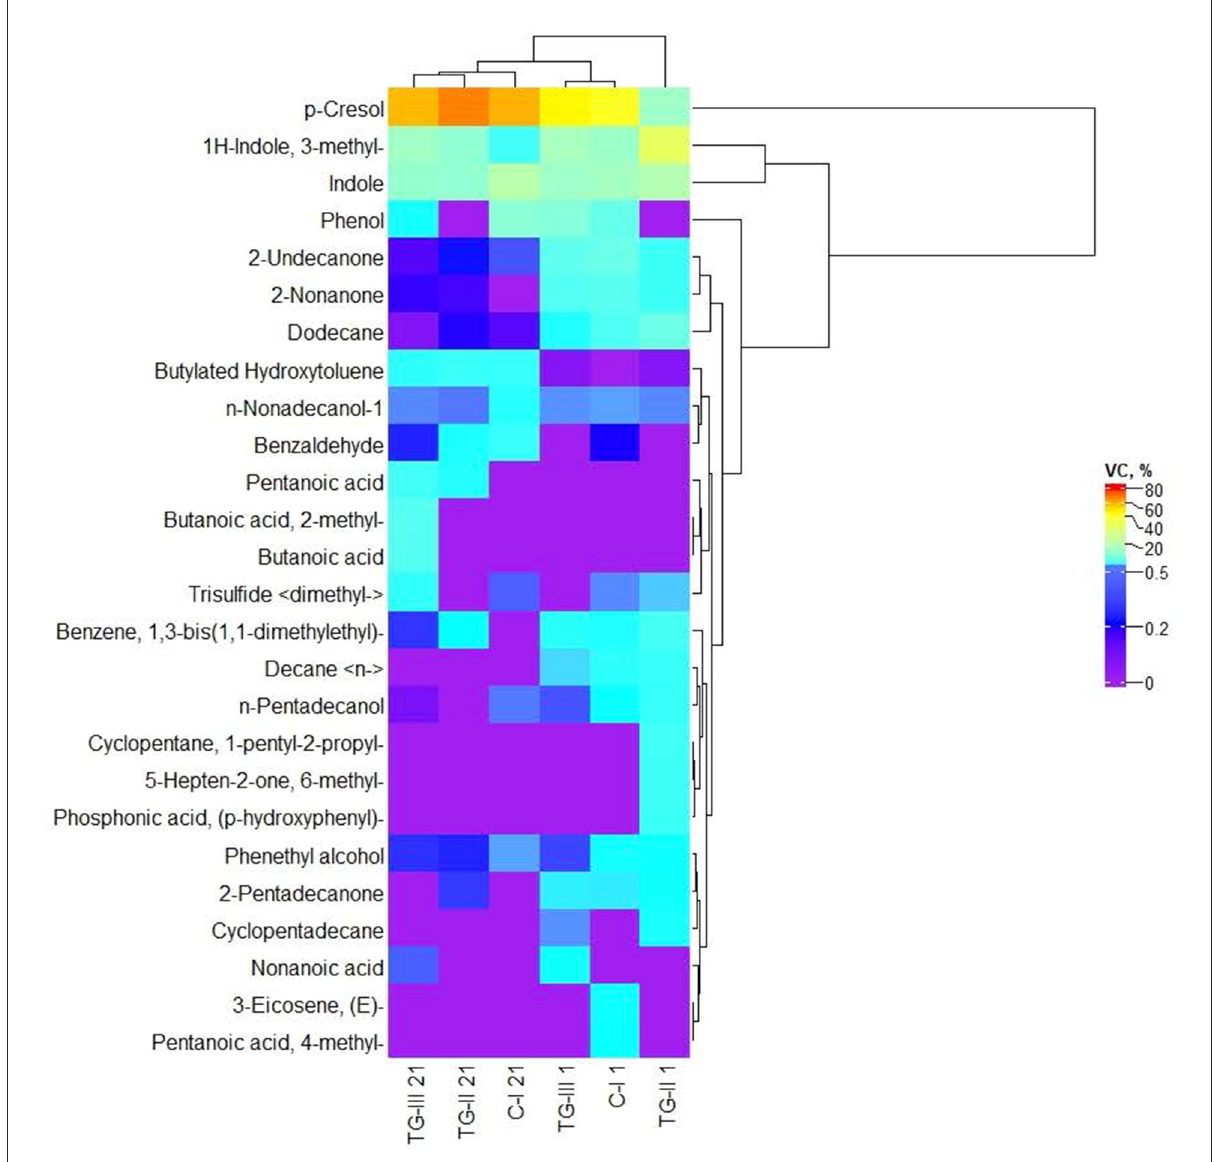
FIGURE2 Volatile compound (VC) profile of piglet feces [(i) basal diet (C-I – control group), (ii) basal diet with extruded-fermented wheat bran added (TG-II), (iii) basal diet with dried sugar beet pulp (TG-III)].